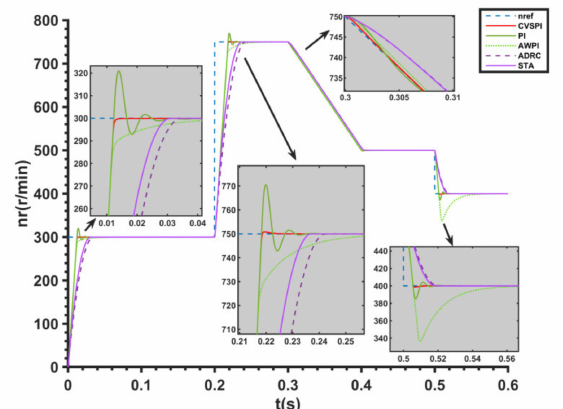
Figure 11. Comparison of the given speed with the actual speed.